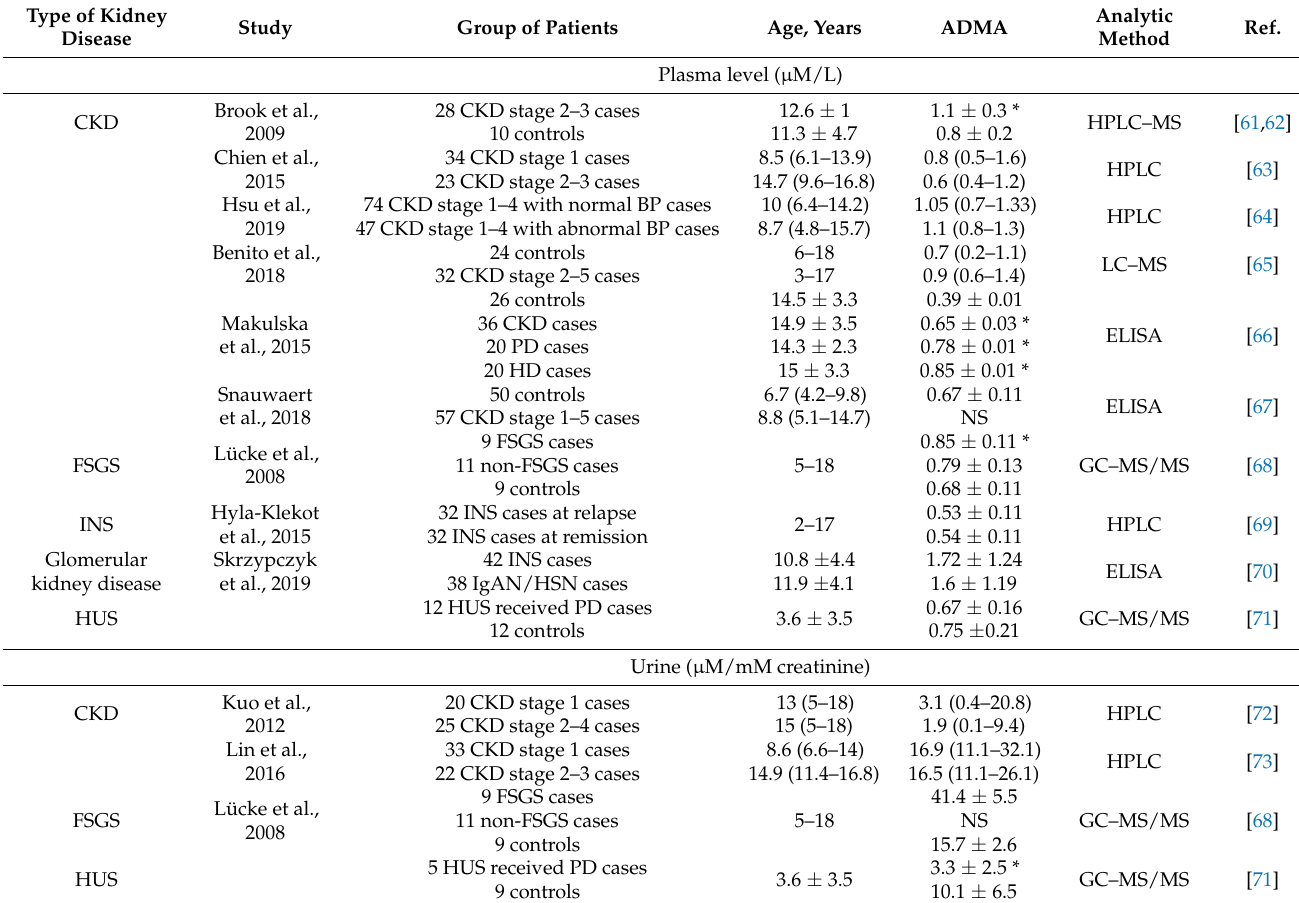
Table 1. Concentrations of ADMA in children and adolescents with kidney